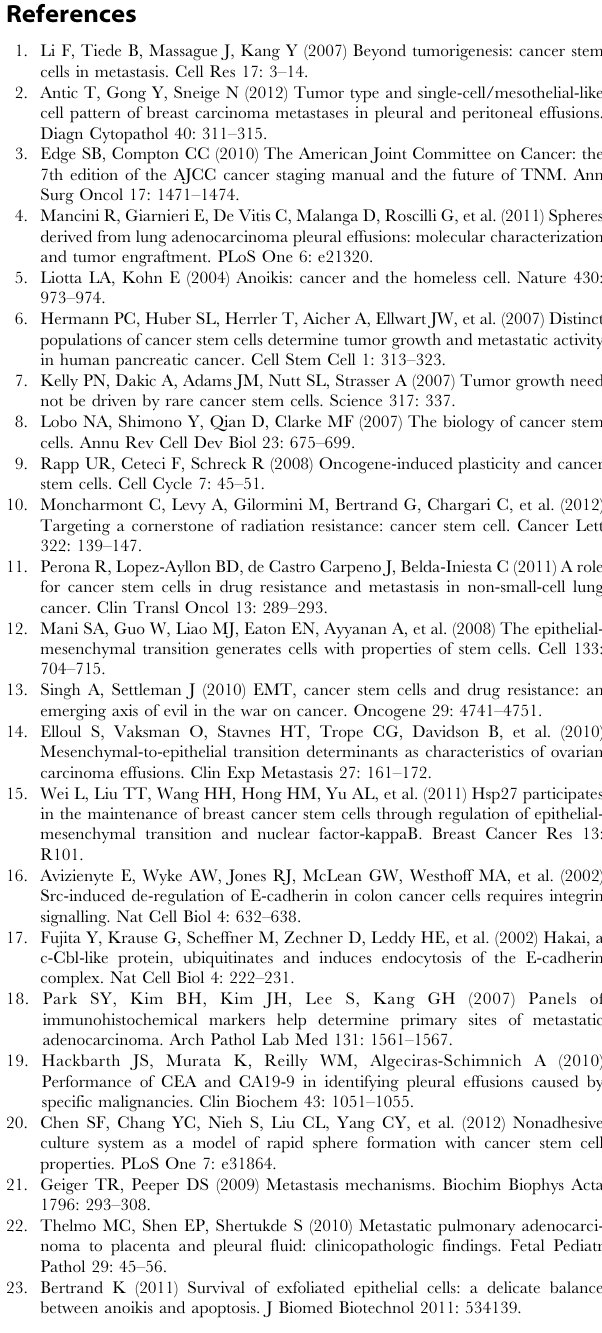
Table S1 The original data including gender, age, TNM, and immunoexpression of three CSC-representa- tive markers in 20 patients with MPE. Table S2 Three groups of representative primary antibodies chosen for identification: pulmonary adeno- carcinoma-confirming markers, EMT-associated mark- ers and CSC-representative markers. Table S3 Oligonucleotide sequence of primers used for